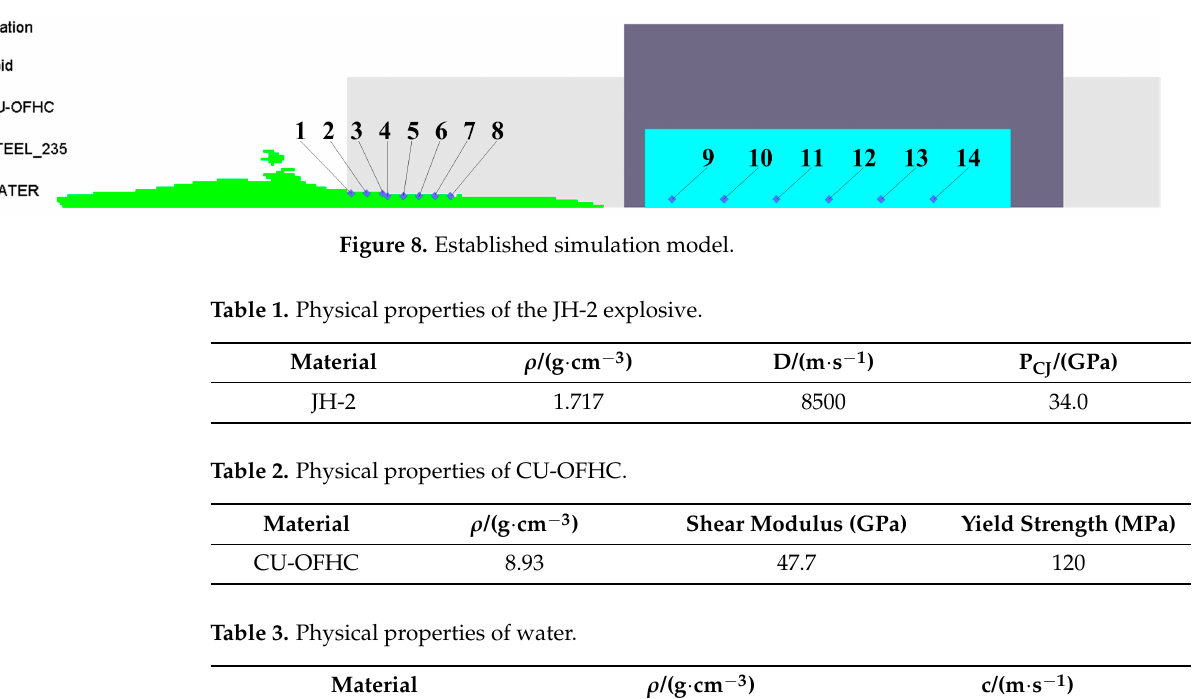
Figure 7. Jet velocity distribution at 24 µs.